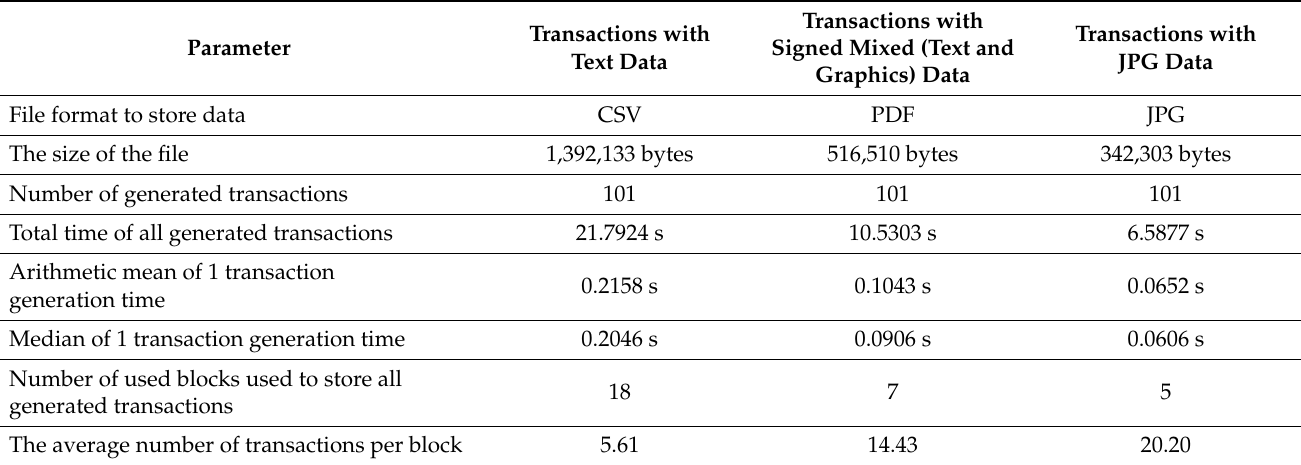
Table 3. The performance evaluation results of the selected BIoMT